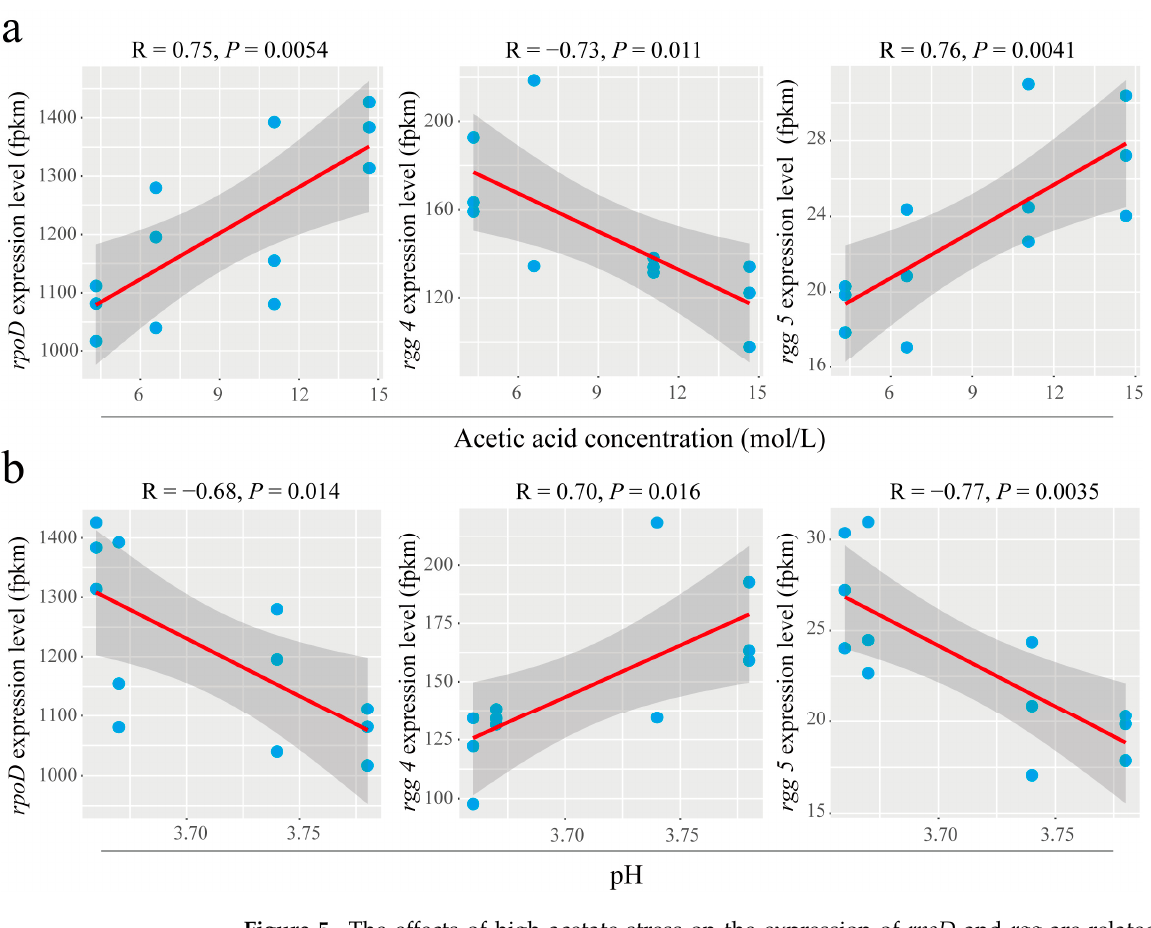
Figure 5. The effects of high acetate stress on the expression of rpoD and rgg are related to the extracellular acetic acid concentration and pH. ( a ) Linear analysis of rpoD expression level and acetate concentration; ( b ) linear analysis of rpoD expression level and pH value. The results of linear regression analysis in the panel are shown as best-fit trendlines for each sampling site (the shaded areas depict the 95% confidence interval).